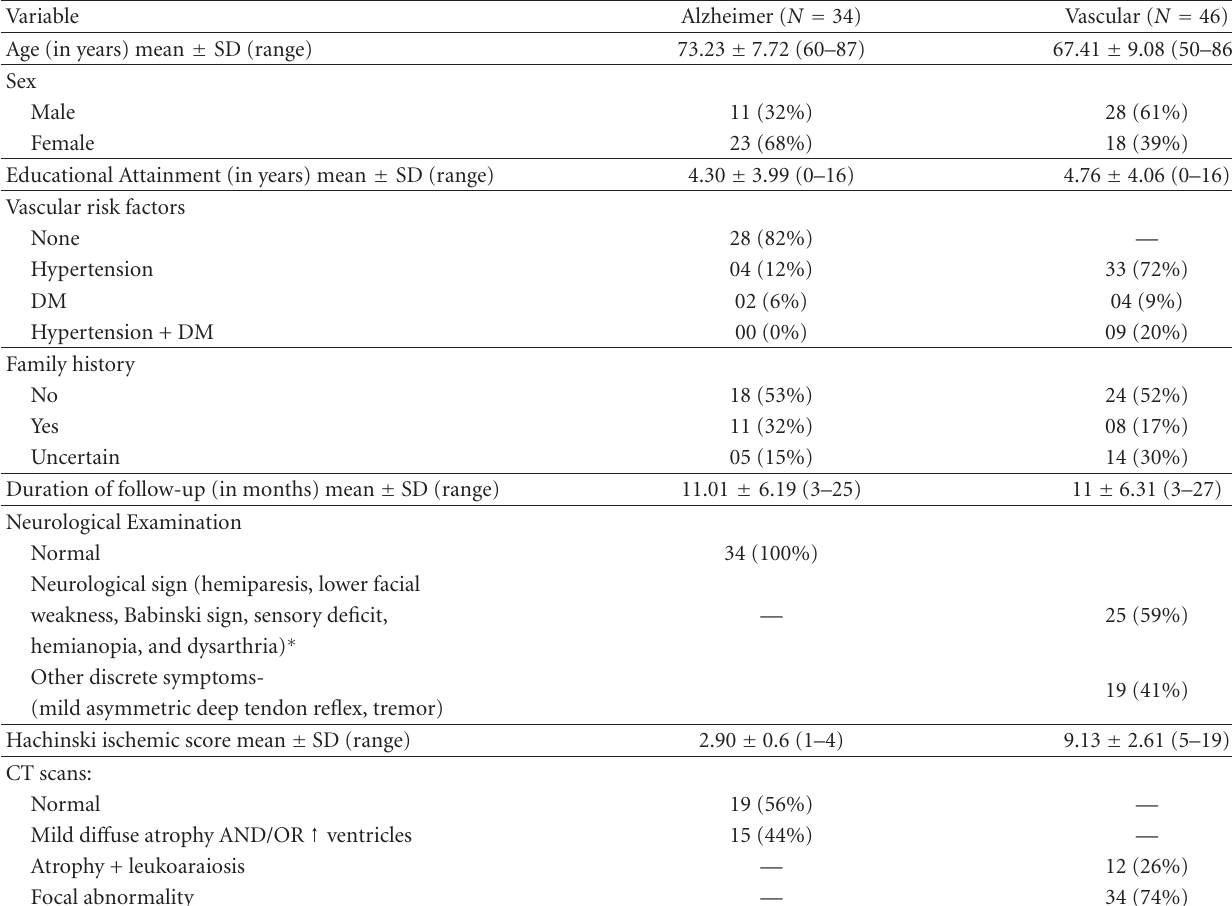
Table 1: Demographic and clinical data at study